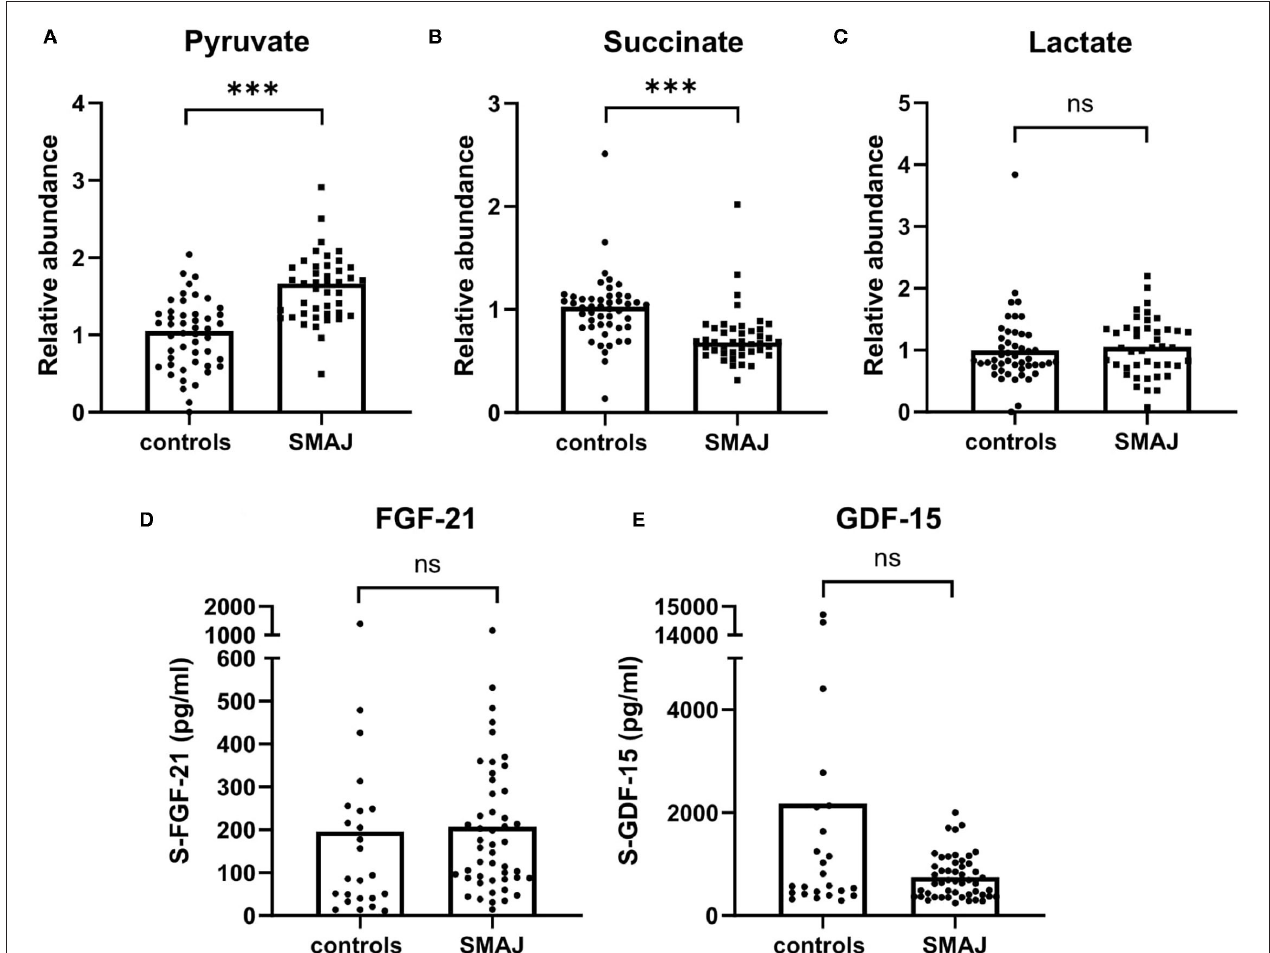
FIGURE 3 | Mitochondrial disease biomarkers in SMAJ. Comparison of (A) pyruvate, (B) succinate, and (C) lactate values between patients with SMAJ ( n = 43) and controls ( n = 48) measured with a mass spectrometer. Comparison of (D) FGF-21 and (E) GDF-15 levels between patients with SMAJ patients ( n = 49) and controls ( n = 24) measured by ELISA assays. Median per group is indicated by a bar. *** p < 0.0001, Mann–Whitney U